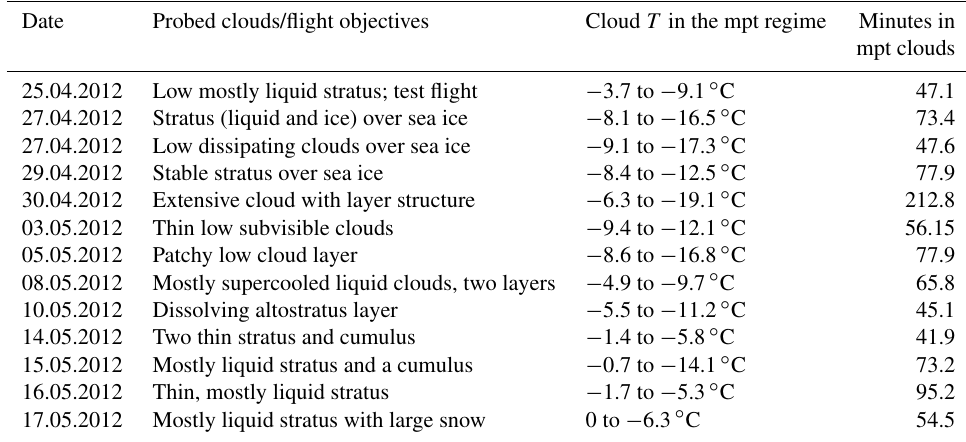
Table 3. Flight table for VERDI. Dates are